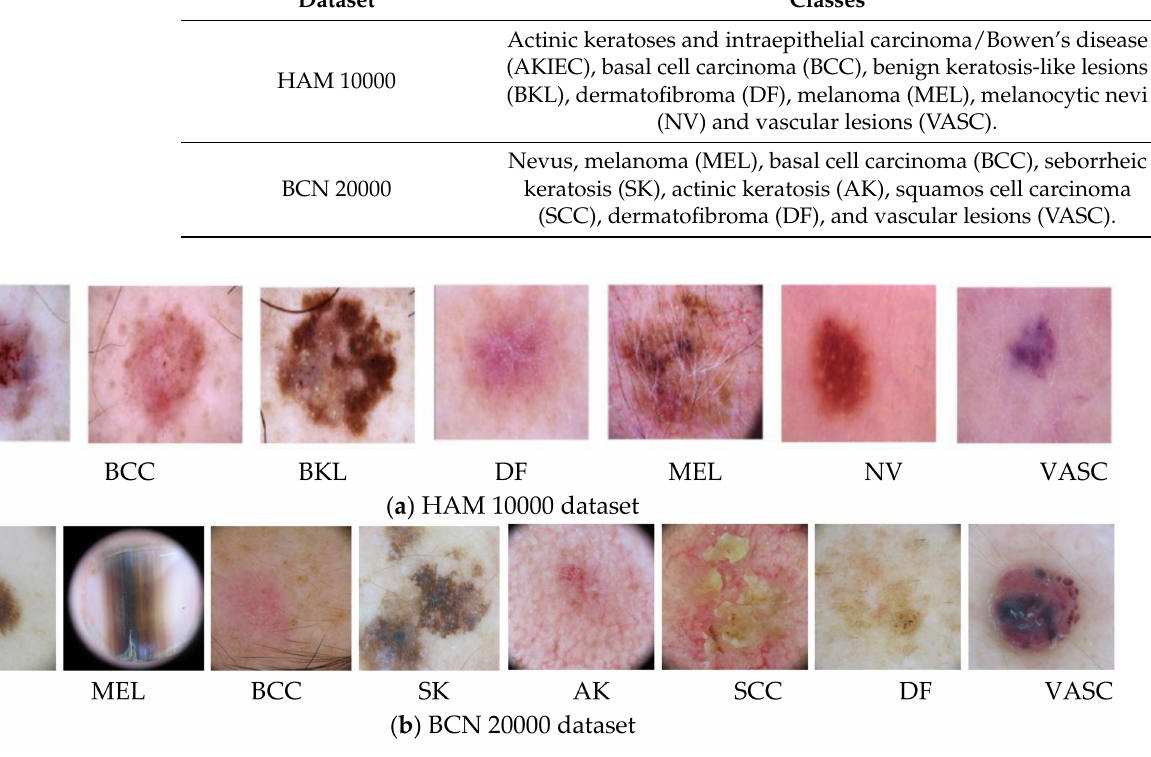
Figure 5. The skin lesions of ( a ) HAM 10000 and ( b ) BCN 20000 datasets.